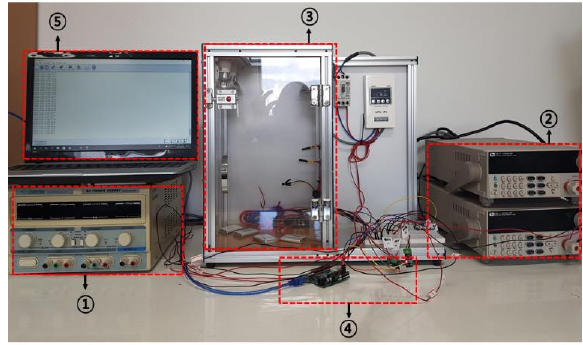
Figure 7. Experimental environment for the SOC estimation simulation.